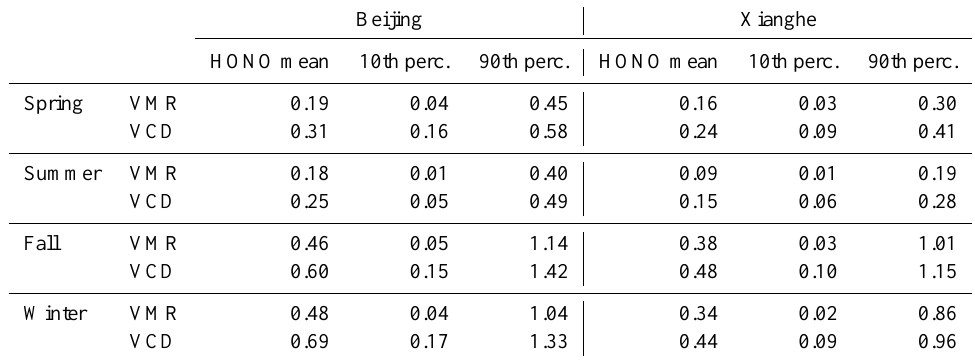
Table 4. Mean HONO/NO 2 ratio (VMR/VMR and VCD/VCD) around local noon ( ± 2h) at Beijing and Xianghe. The 10th and 90th percentiles of the data are also given. Beijing Xianghe HONO/NO 2 mean 10th perc. 90th perc. HONO/NO 2 mean 10th perc. 90th